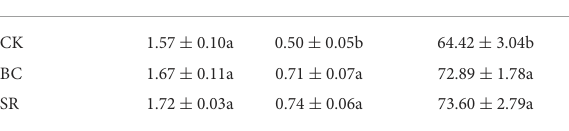
The error bars represent the standard deviations of the mean values (n = 3). Different lowercaselettersindicatesignificantdifferencesbetweenthe differenttreatments.MWD, meanweightdiameter;GMD,geometricmeandiameter.